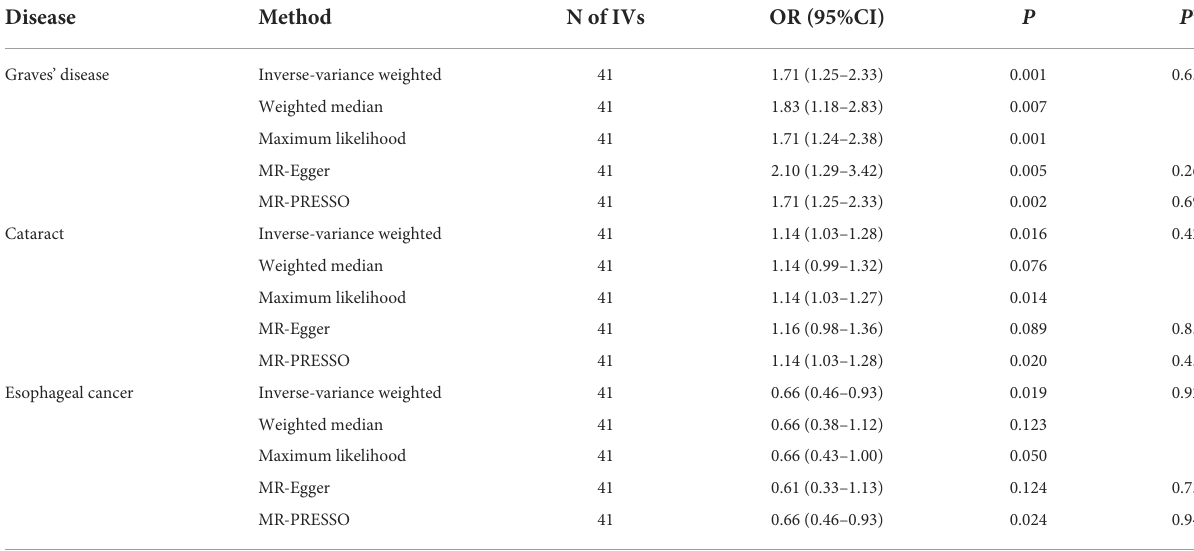
TABLE 1 Causal link between genetically predicted vitamin D in European population and diseases identified in individuals from Biobank Japan. Disease Graves’ disease